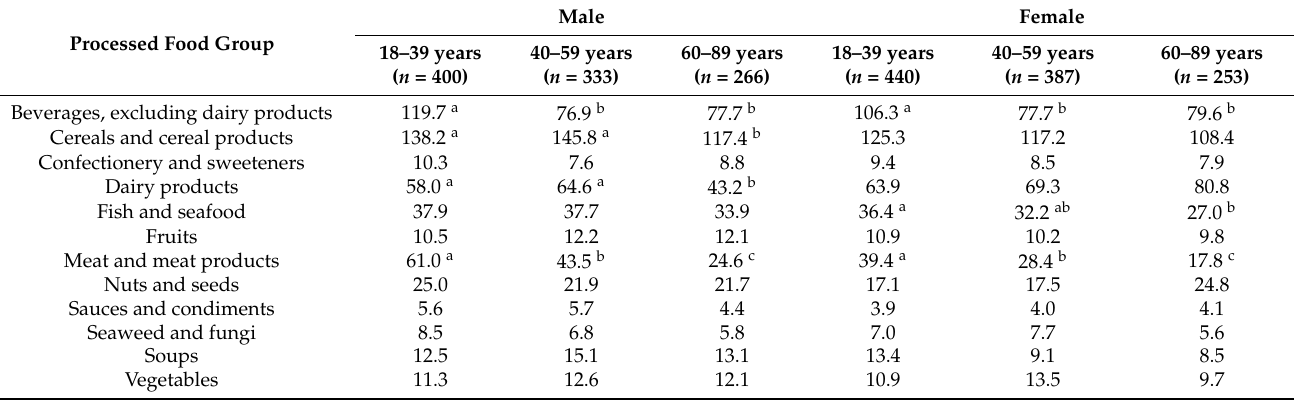
Table 4. Mean daily intake of consumers analysed by gender and age